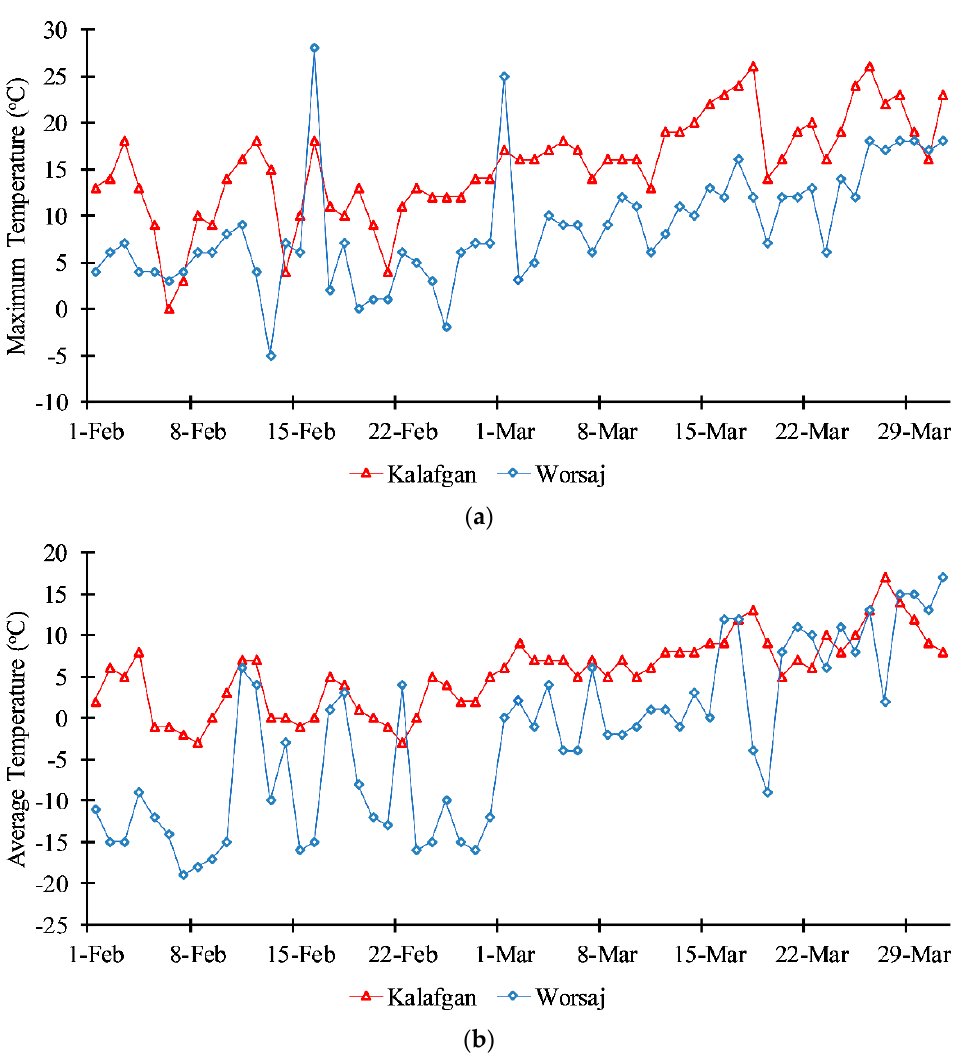
Figure 10. Maximum and mean daily temperatures of Kalafgan and Worsaj as determined from data available from AccuWeather Pvt. Ltd. for February and March 2019.